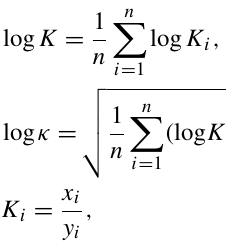
of − 0.42 m was set at the time of the tsunami occurrence,